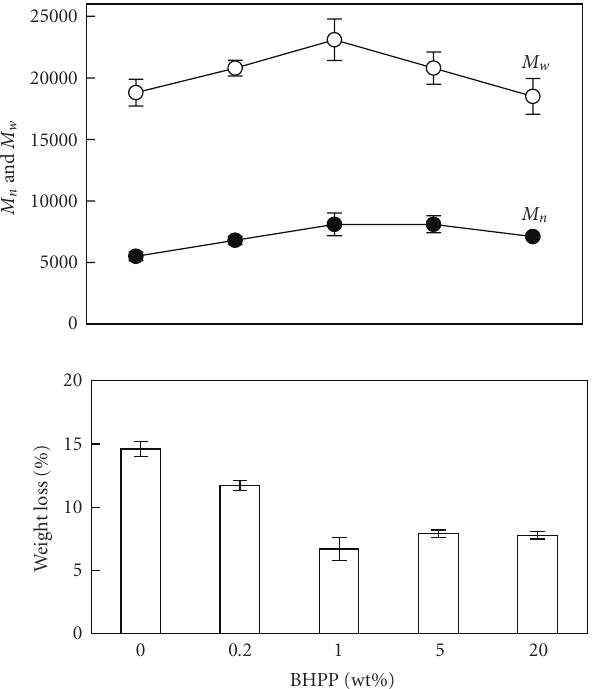
Figure 10: Weight loss values and average molecular weights of PLLA in PLLA/BHPP blends after heating at 300 ◦ C for 30 minutes. Bar: standard